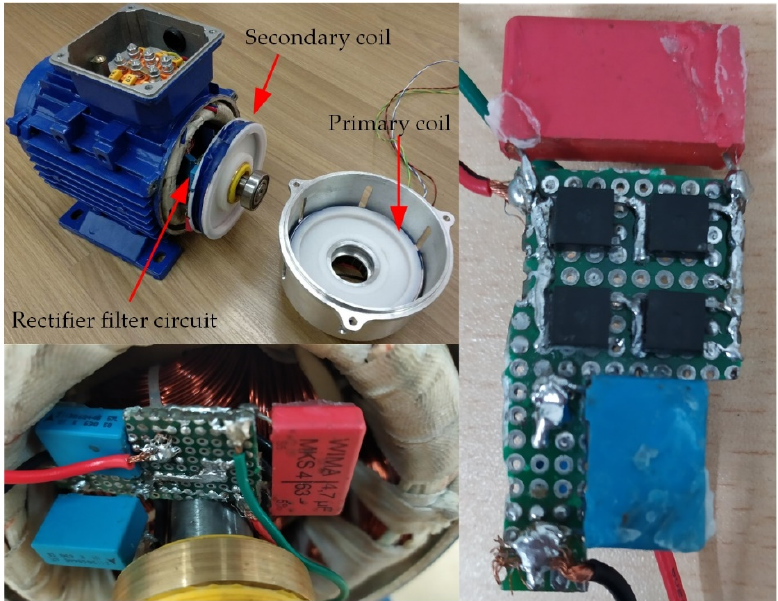
Figure 11. The RW-EESM prototype.